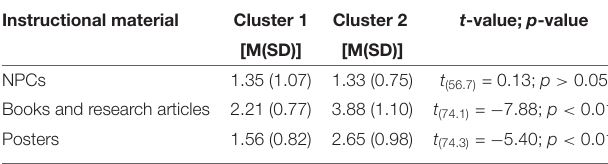
TABLE 2 | Recurrent point frequency between clusters 1 and 2. Instructional